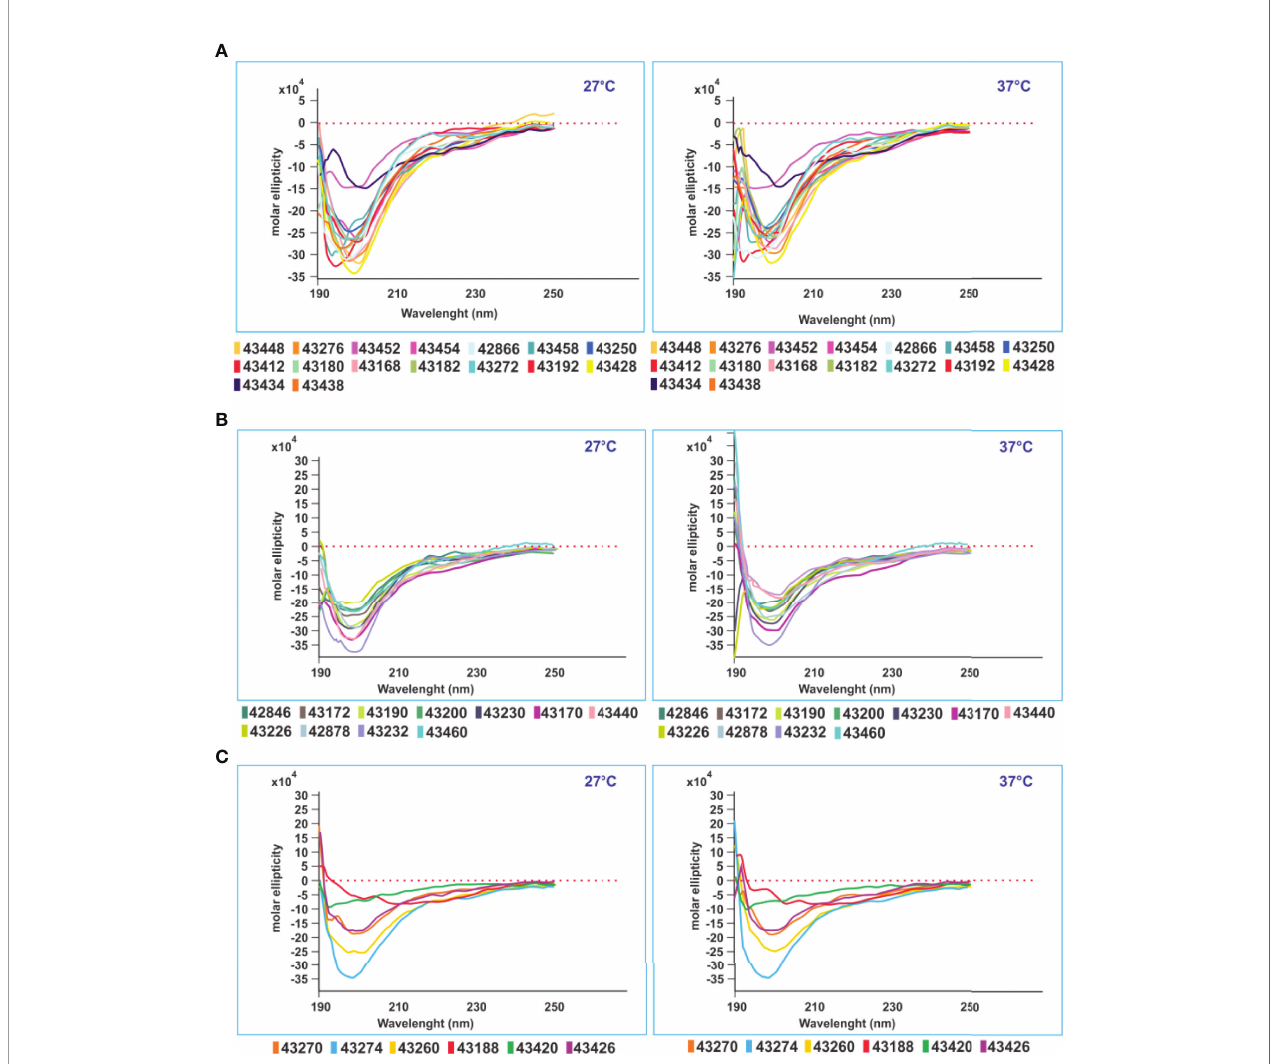
FIGURE 9 | CD structural analysis. CD structural analysis revealed three immunological result-associated structural patterns. (A) Sixteen modi fi ed peptides having random coil structure with very deep negative ellipticity at 190 nm (starting below 0 at 27° and 37°C) associated with high Ab levels against native parental peptides. (B) Eleven modi fi ed SM-COLSARSPROT peptides inducing high classical negative ellipticity-associated Ab titres at 190 nm (same parameters). (C) Six modi fi ed peptides inducing very low Ab levels against native parental peptides had the same negative ellipticity at 190 nm (same parameters), all having random coil secondary